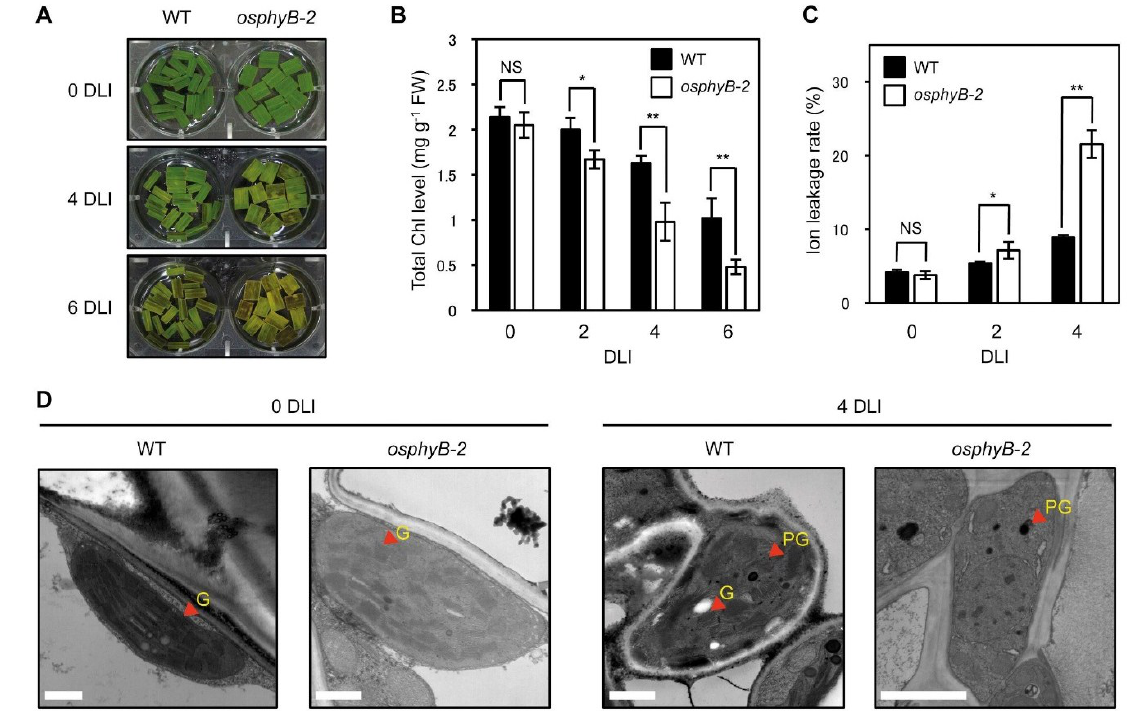
Figure 3. The osphyB -2 mutants senesced early even in light conditions. The changes of phenotype ( A ); total Chl level ( B ); ion leakage rate ( C ); and chloroplast structure (observed